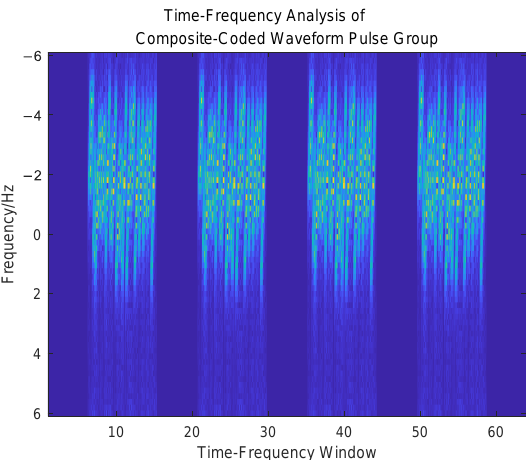
Figure 5. Time-Frequency Analysis of Joint Coding Waveform.